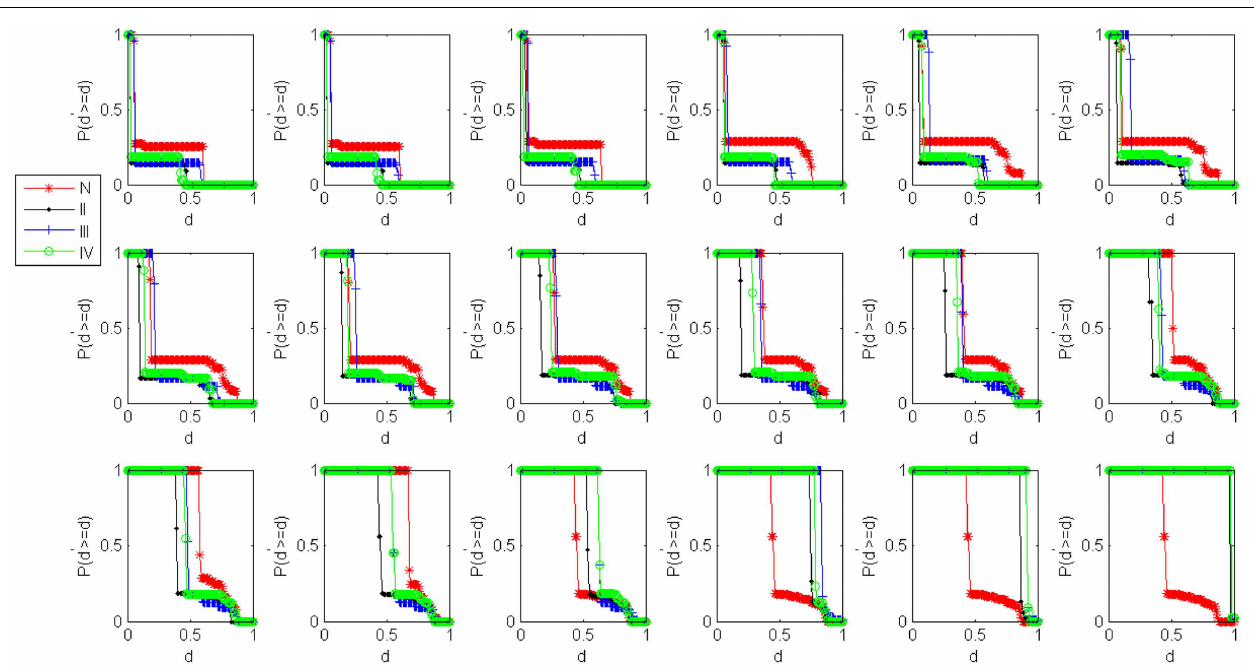
FIGURE 3 | Damage distributions for cascading events in glioma networks. Plots of the cumulative probability of size-ratio of cascading failure P ( d (cid:48) ≥ d ) versus the size of cascading failure of node d in 18 threshold values.The red, black, blue, and green curves correspond to the cases of the normal state, stage II, stage III, stage IV respectively.